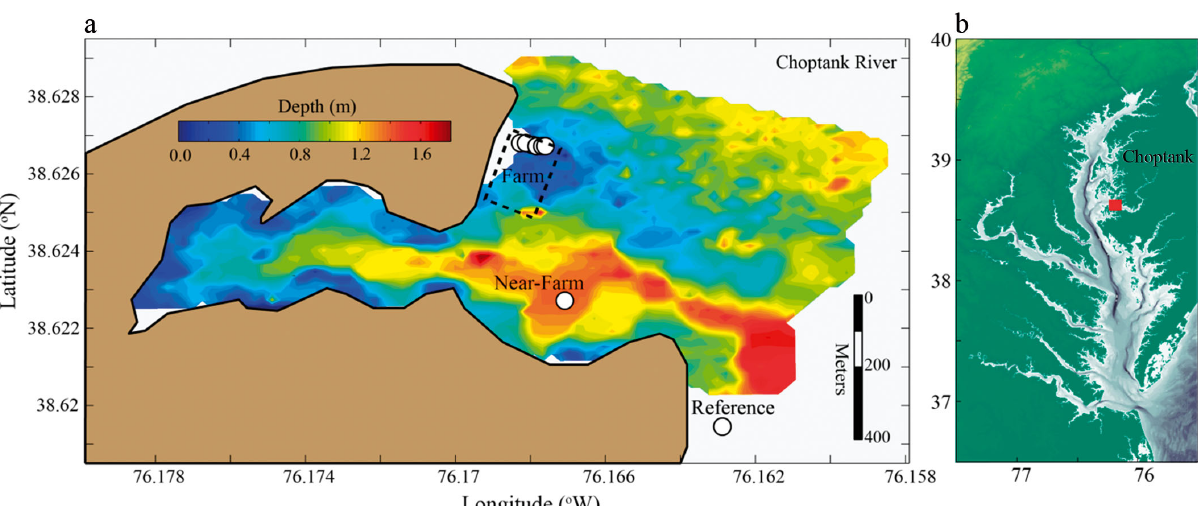
Fig. 1. (a) Map showing location of the farm, near-farm and reference sites in the Choptank River, (b) a tributary on the eastern shore of Chesapeake Bay. Contours represent local bathymetry relative to mean lower low water, and white circles represent